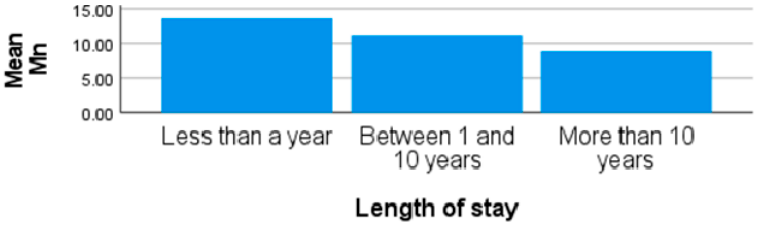
Figure 1. Showing blood Mn by length of stay in obese females living around site 3. The mean concentration of Cr from site 3 was 6.16 ± 6.30 µg/l and in the range of 1.58–29.29 µg/L. From participants in site 1, Cr concentrations recorded a mean and